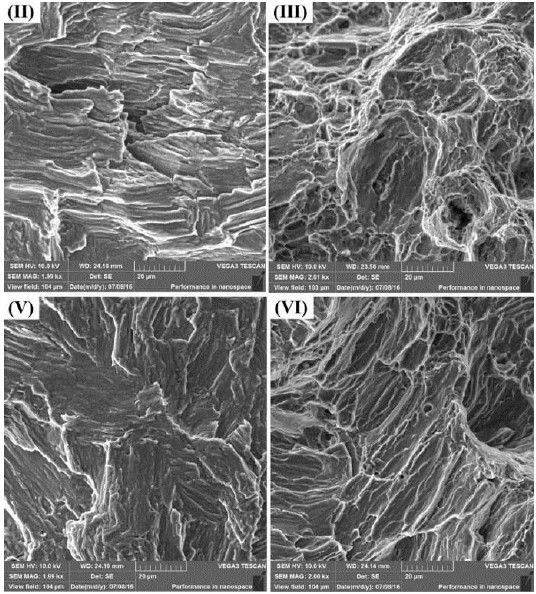
Figure 12. The high magnification images of as-received and HFIR specimens corresponding to Figure 10. ( II ) Crack propagation region of as-received specimen and ( III ) Instantaneous fracture region of as-received specimen. ( V ) Crack propagation region of HFIR specimen and ( VI ) Instantaneous fracture region of HFIR specimens.